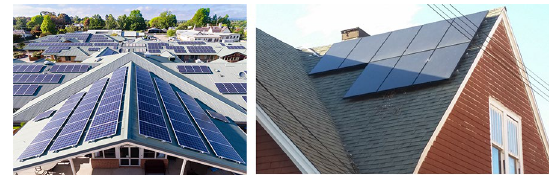
Fig. 1 Deployment of distributed PV systems with a complex